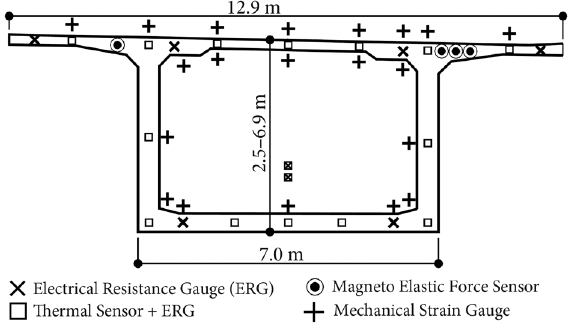
fig. 2. Layout of measuring instrumentation in section IV